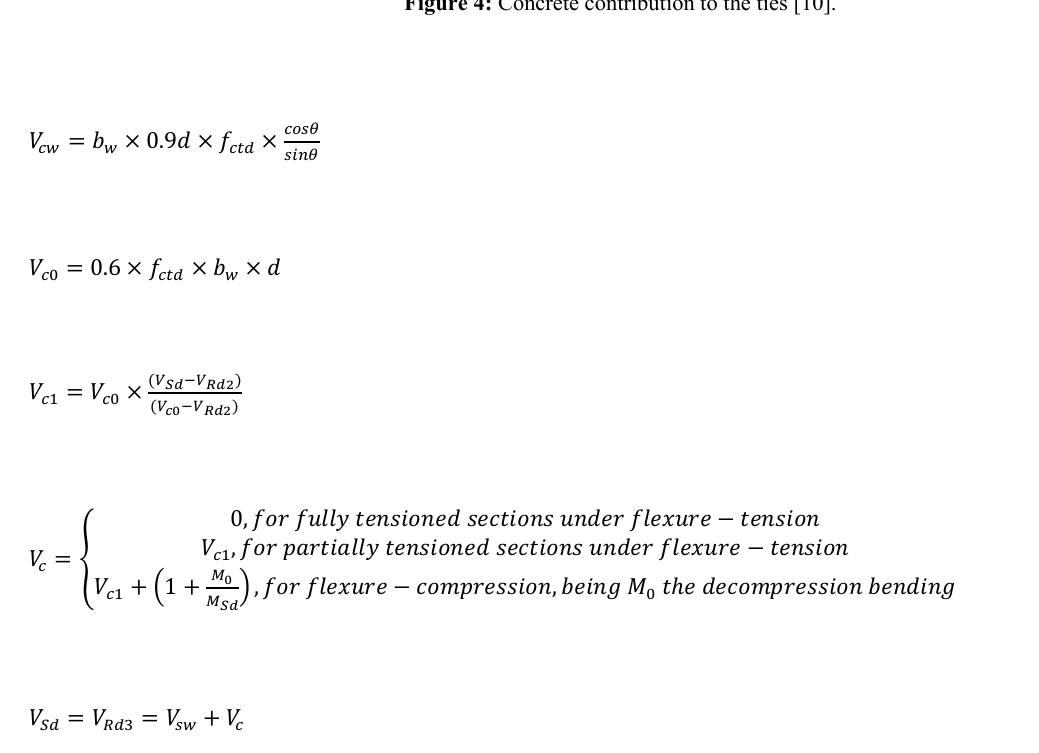
Figure 4: Concrete contribution to the ties